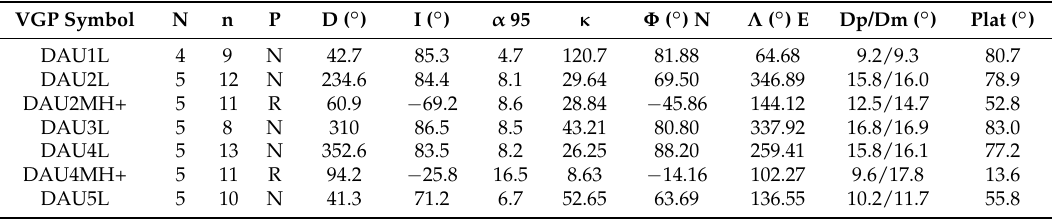
Table 3. VGPs calculated for components identified in metadolerites from SW Oscar II Land, Western Spitsbergen (average sampling location 78 ◦ N, 13.5 ◦ W), qualified for further tectonic interpretation ( κ > 10, α 95 < 17 ◦ ; Table 2). Explanations: P—polarity (N—normal; R—reverse); Φ